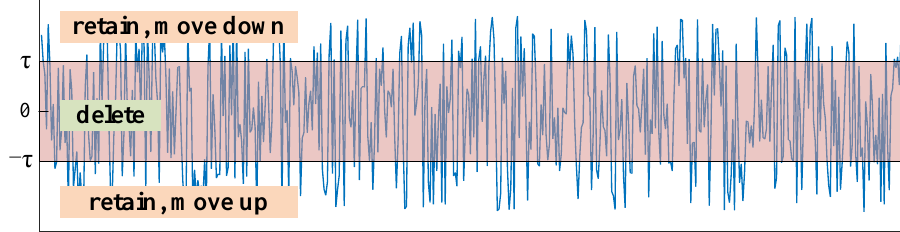
Figure 11. The soft thresholding function when 𝑏 = 0 .